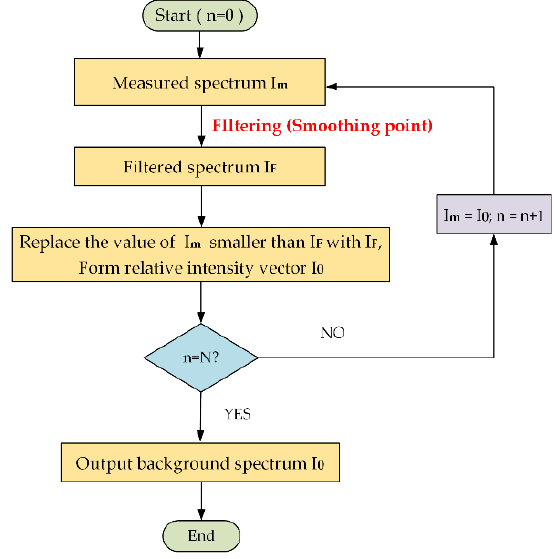
Figure 8. The background spectrum acquisition method.